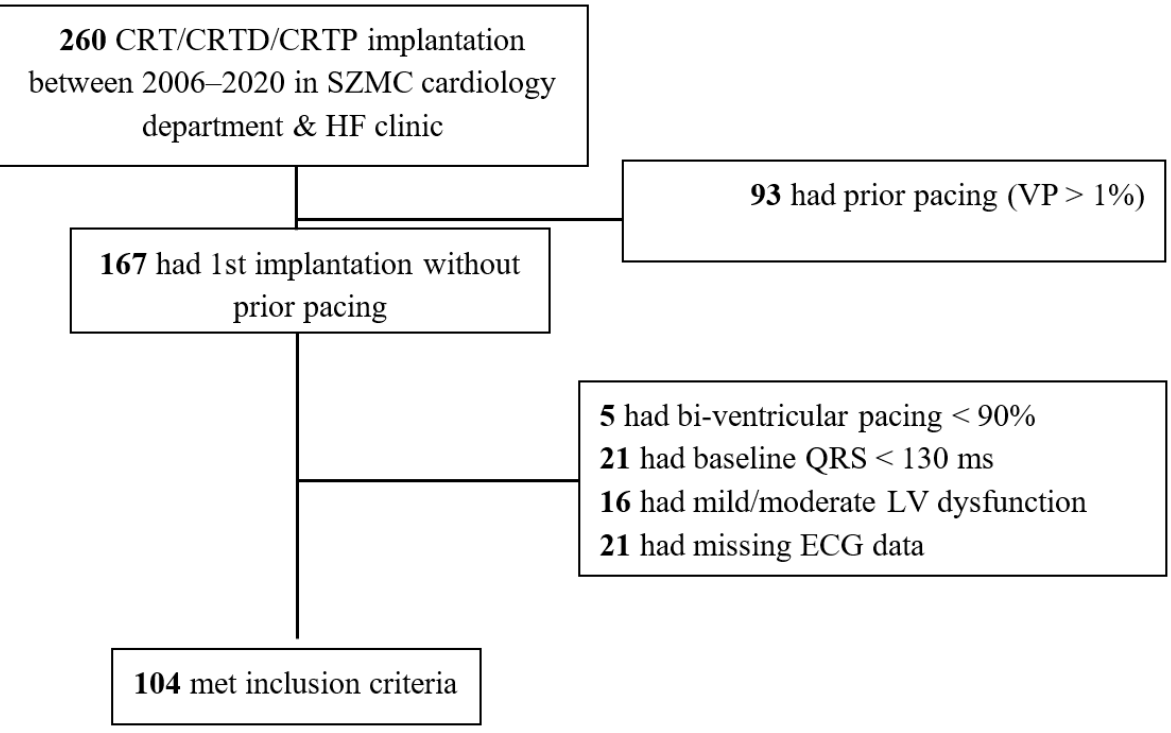
Figure 1. Patient inclusion flowchart.